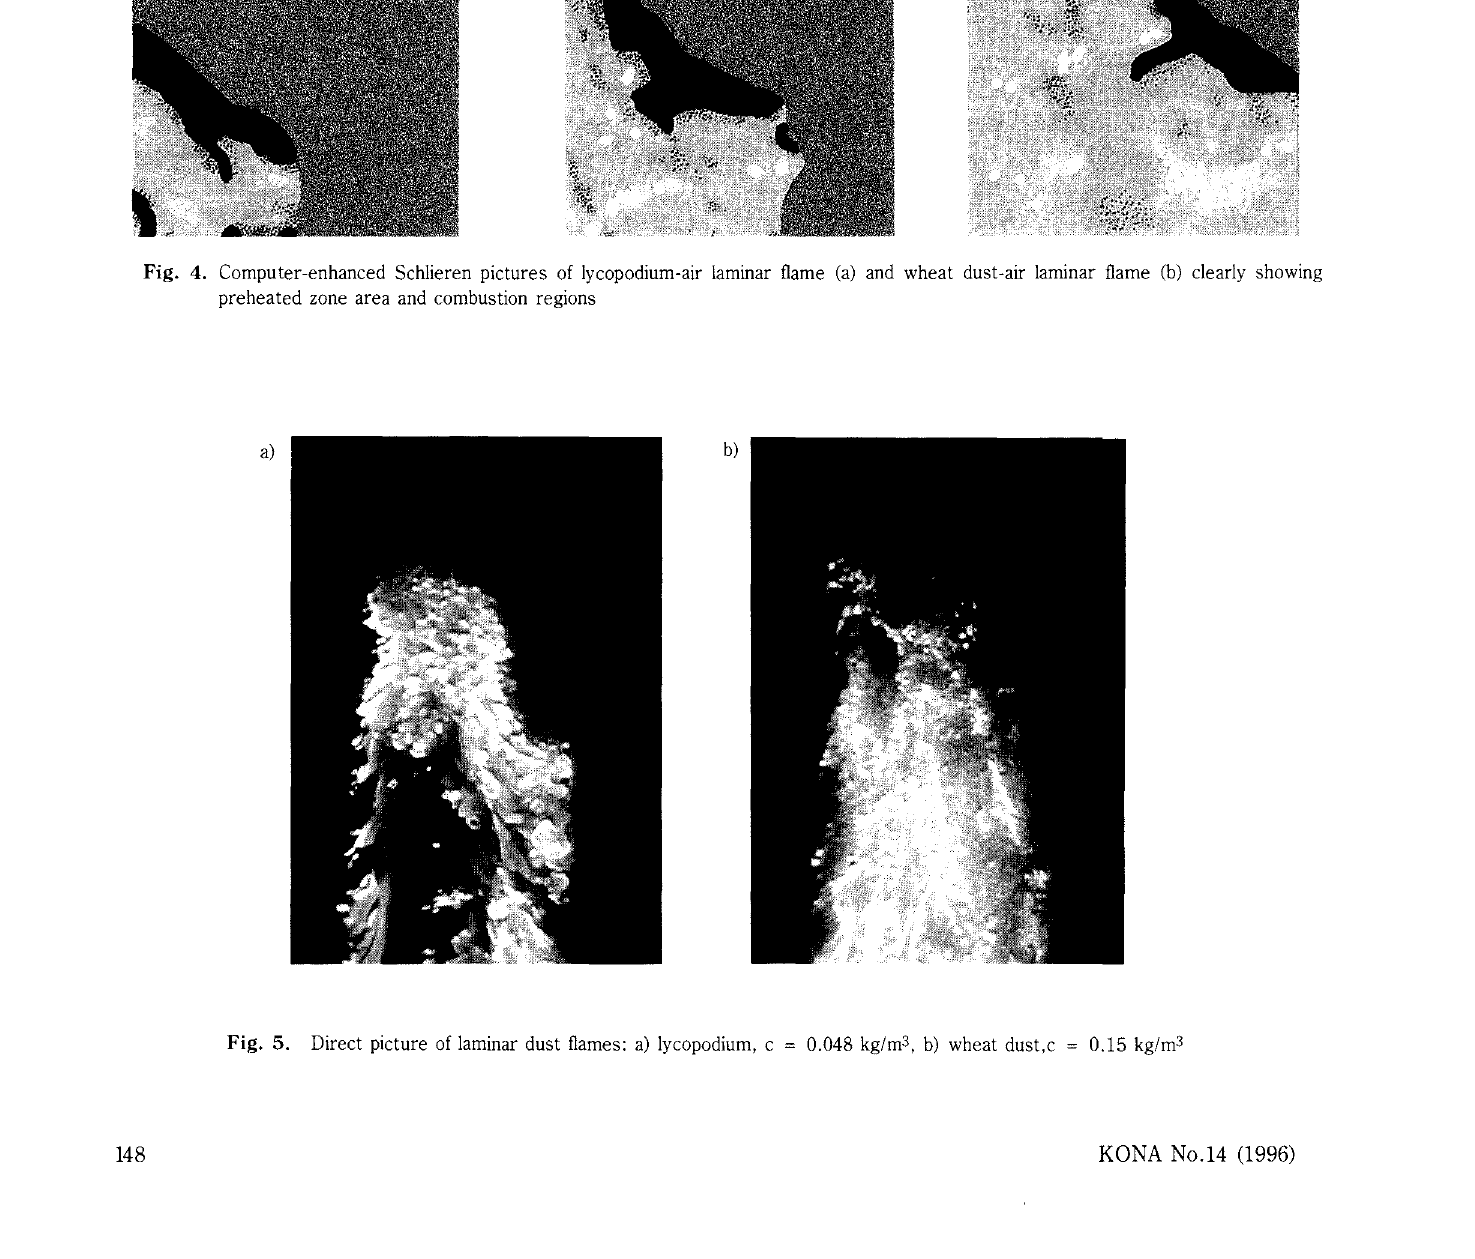
Fig. 5. Direct picture of laminar dust flames: a) lycopodium,